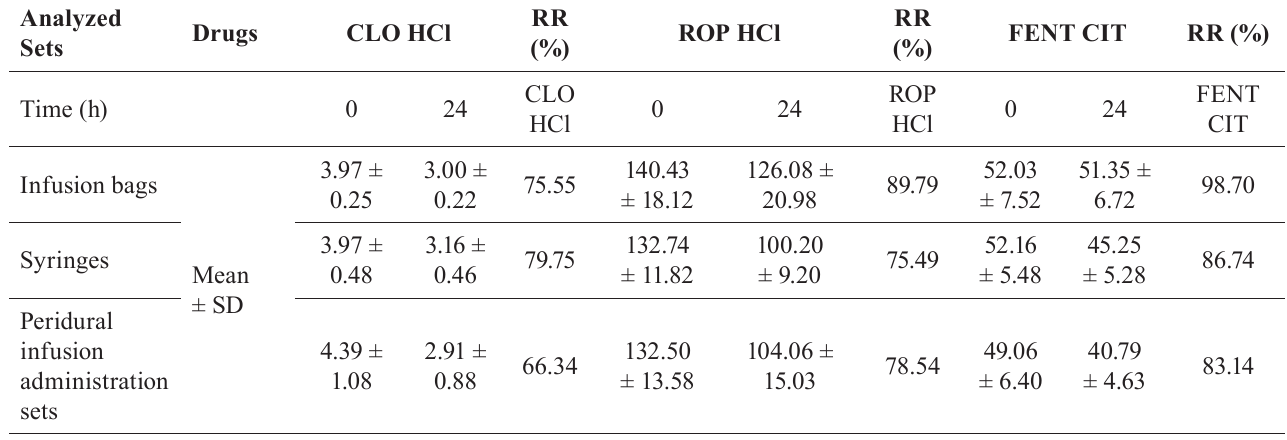
TABLE VII - Results of extended stability study for CLO HCl, ROP HCl and FENT HCl in different sets Analyzed